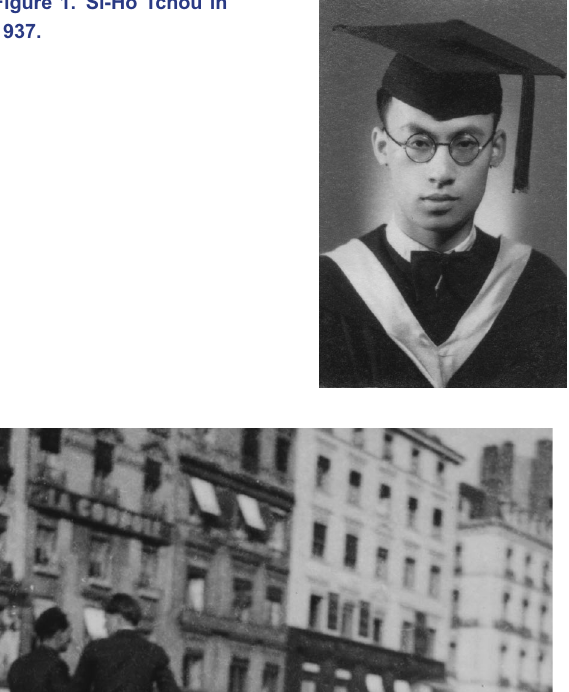
Figure 1. Si-Ho Tchou in 1937.